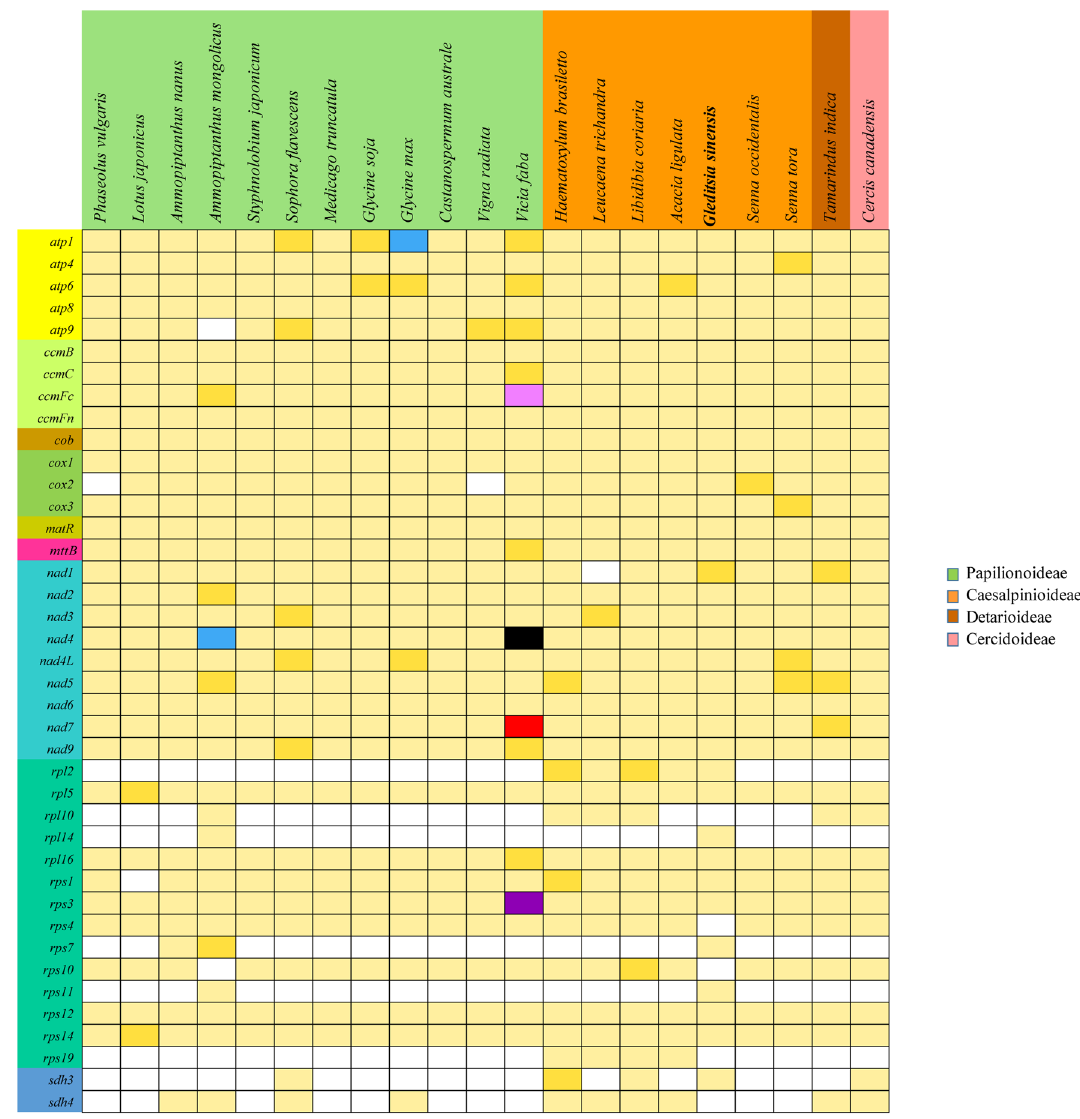
Figure 5. Distribution of PCGs in 22 Fabaceae plant mt genomes. White boxes indicate that the gene is not present in the mt genomes. Light yellow, golden, blue, purple, black, pink and red boxes indicate that one, two, three, four, five, six and twelve copies exist in the particular mt genomes, respectively. Light green, orange, brown and rose red boxes indicate that Papilionoideae, Caesalpinioideae, Detarioideae, Cercidoideae,